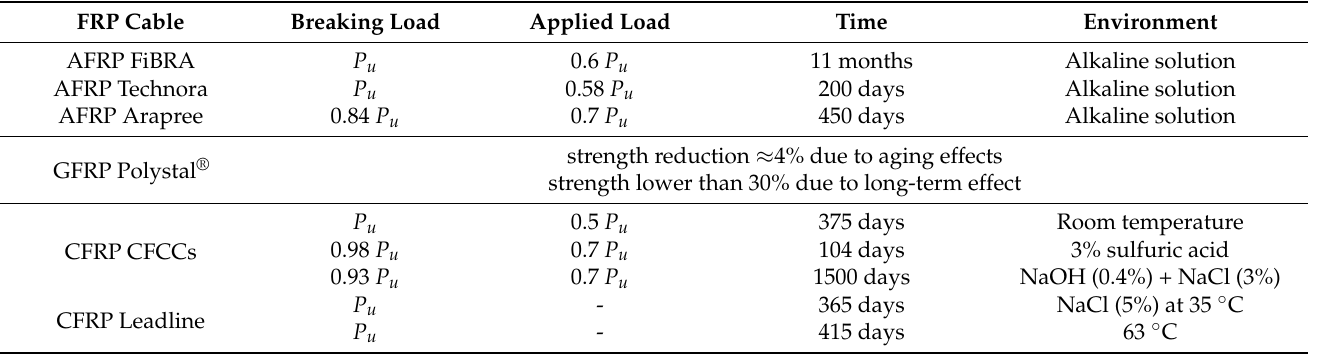
Table 3. FRP composite tendons: environmental and long-term effect.